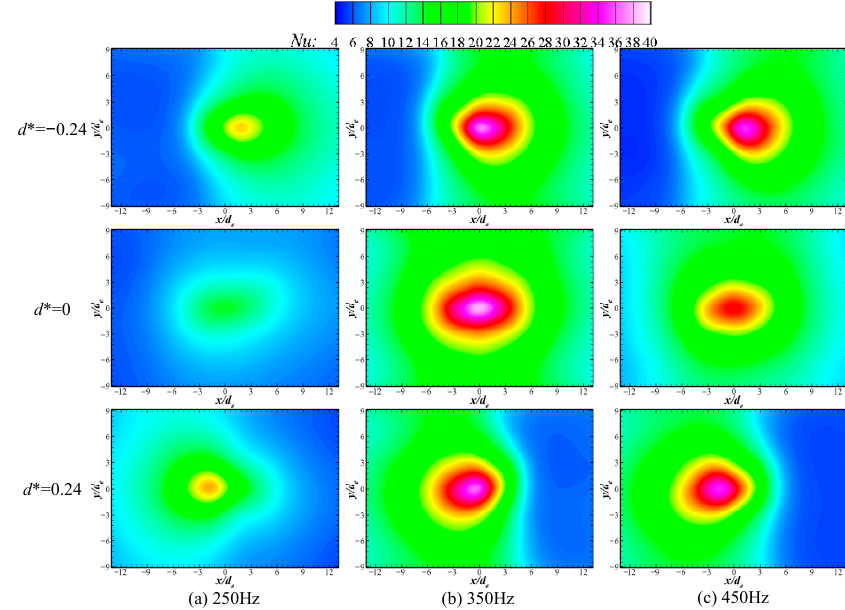
Figure 6. Nu contours at different driving frequencies and slider locations. Nu avg with different drive frequencies and slider locations are shown in Figure